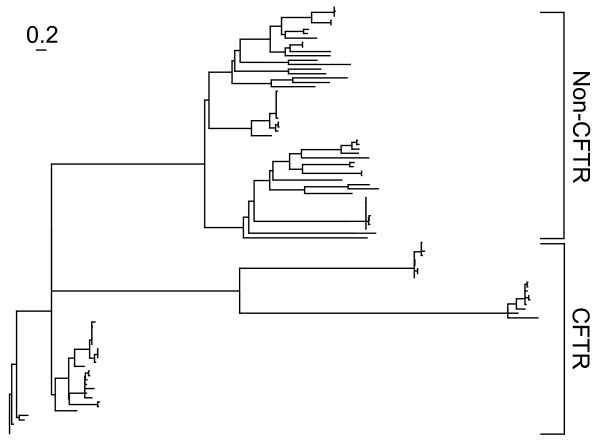
Phylogeny of the ABC-family membrane-spanning domains from PFAM.